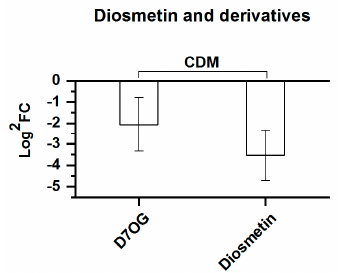
Figure 9. Comparison of diosmetin and its derivatives, comprising 2 CDMs between SJL and SN. Downregulation denotes that the content of a metabolite decreased in SN compared with that in SJL. The Y -axis is exhibited as Log 2 FC values for the convenience of visual presentation. The X -axis denotes the metabolite names. Abbreviation: D7OG, diosmetin-7- O - β - D -glucopyranoside.